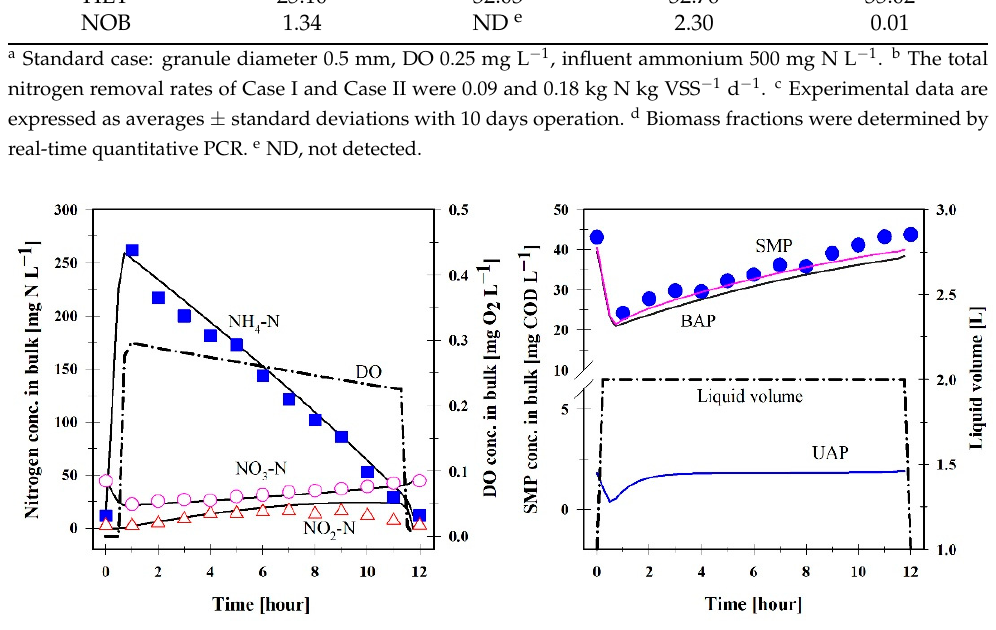
Figure 4. Measured concentrations during one cycle of operation (points: NH 4 -N ( ■ ), NO 2 -N ( △ ), NO 3 -N ( ○ ), SMP ( ● ).) and simulated results with the present model (lines) in the standard case (granule diameter 0.5 mm, DO 0.25 mg L − 1 , influent ammonium 500 mg N L − 1 ).